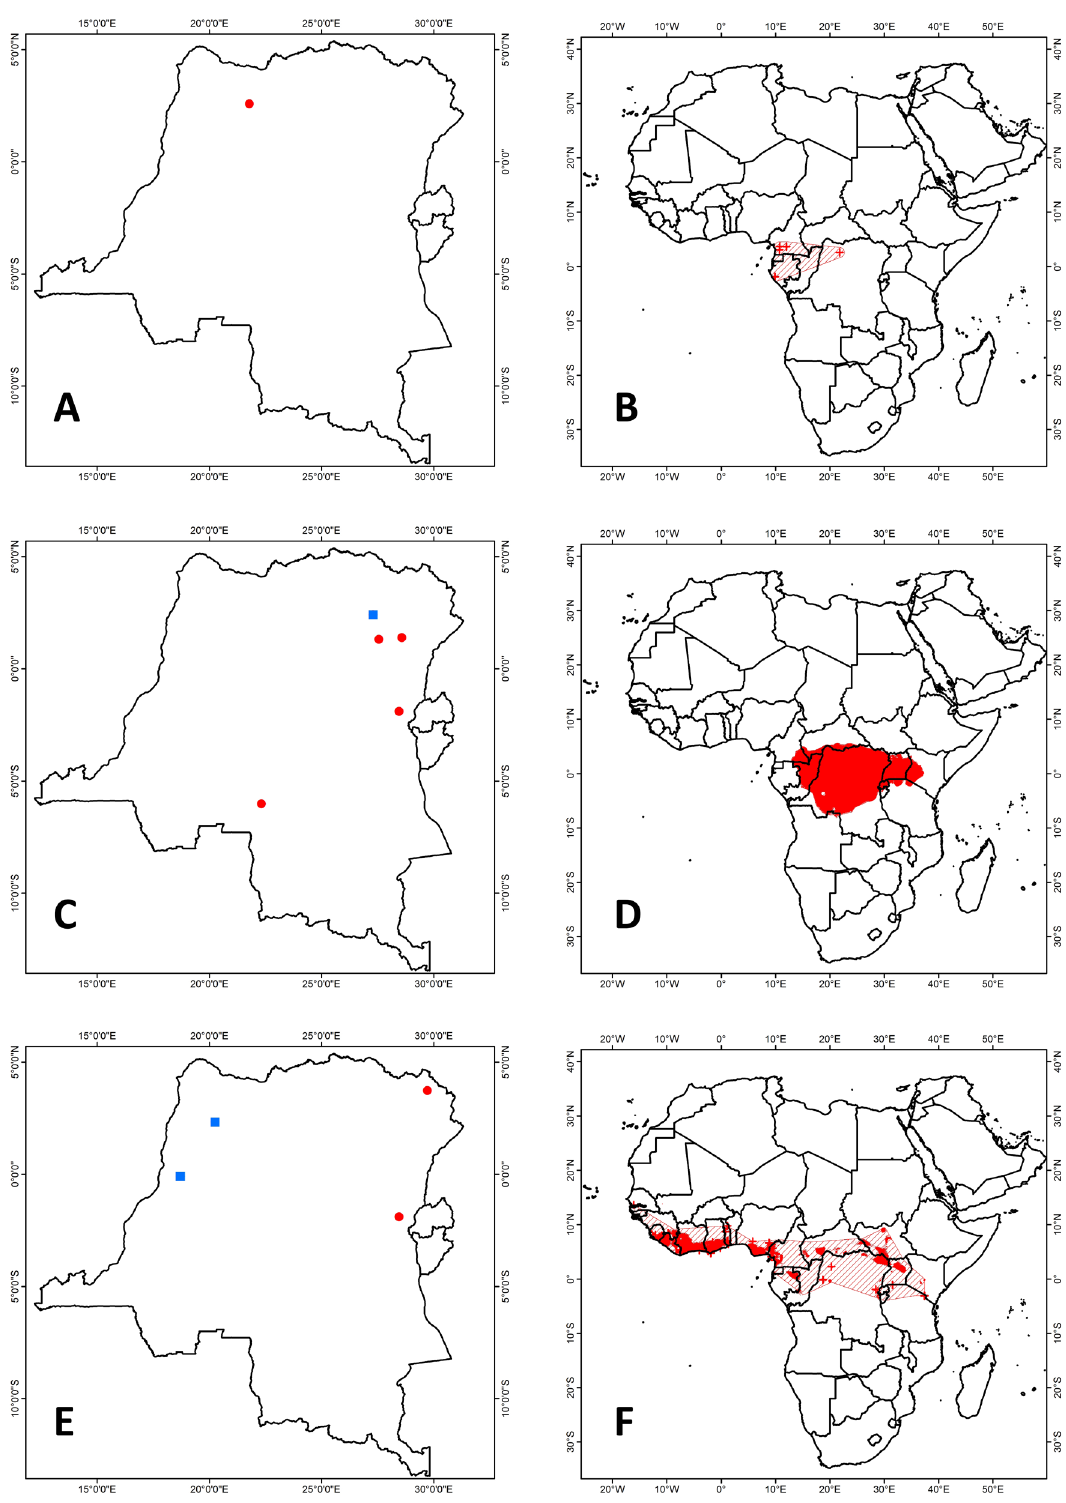
Fig. 39. Distribution maps. A–B . Glauconycteris curryae Eger & Schlitter, 2001. C–D .